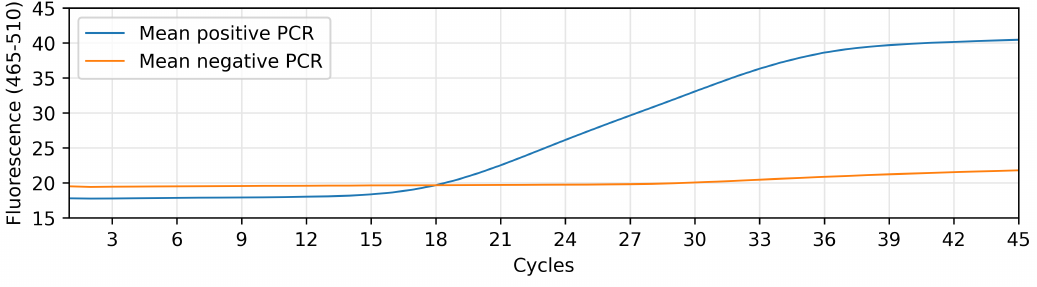
Figure 1. Mean PCR fluorescence signals per cycle of all positive and negative patients of the dataset.